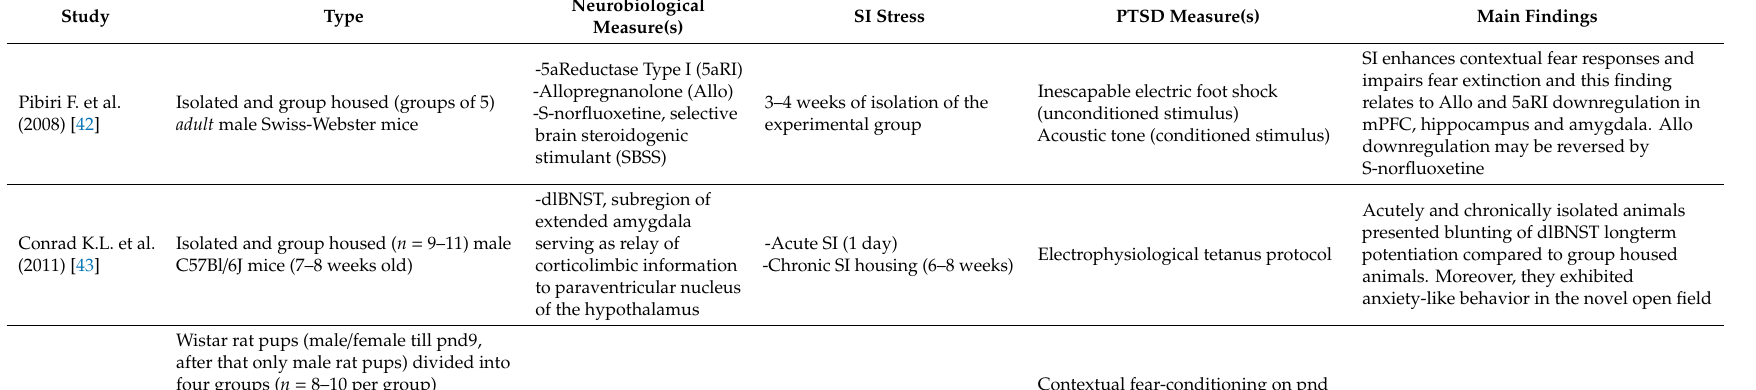
Table 1. Key Characteristics of Included